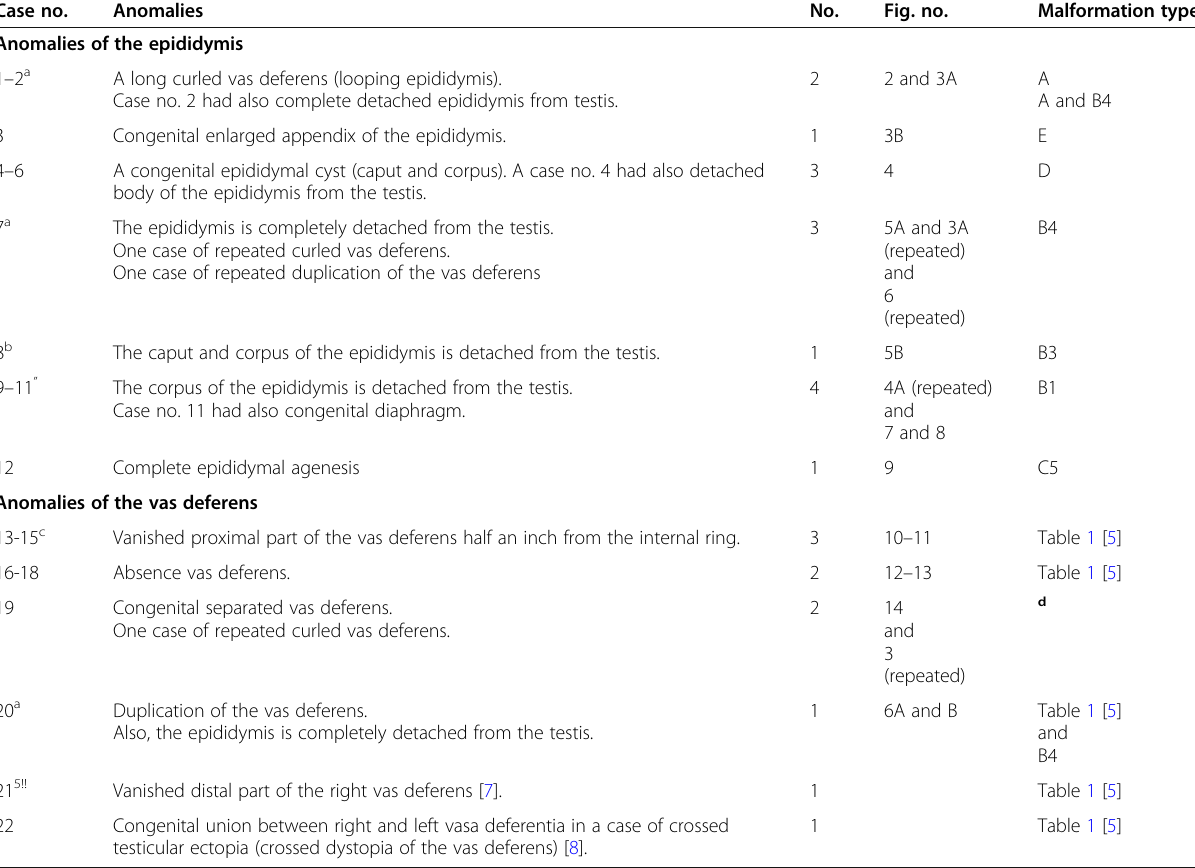
Table 4 Anomalies of the vas deferens and the epididymis detected in our study